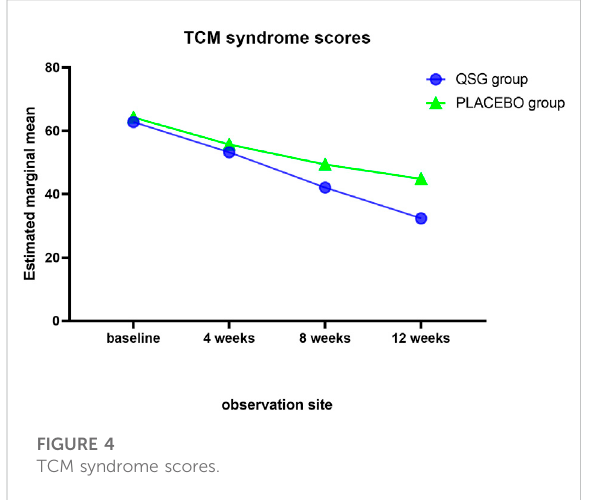
FIGURE 4 TCM syndrome